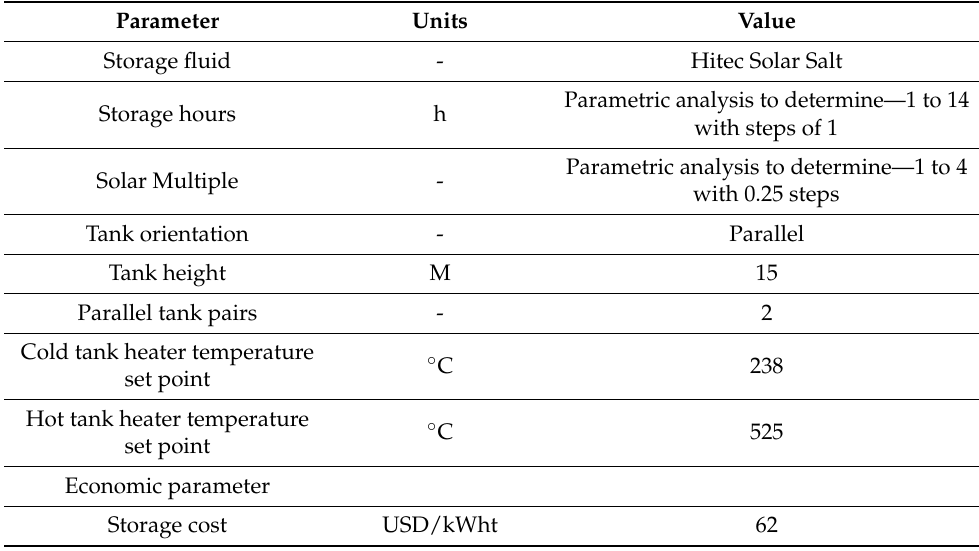
Table 12. TES technical and economic parameters. Data from [30].